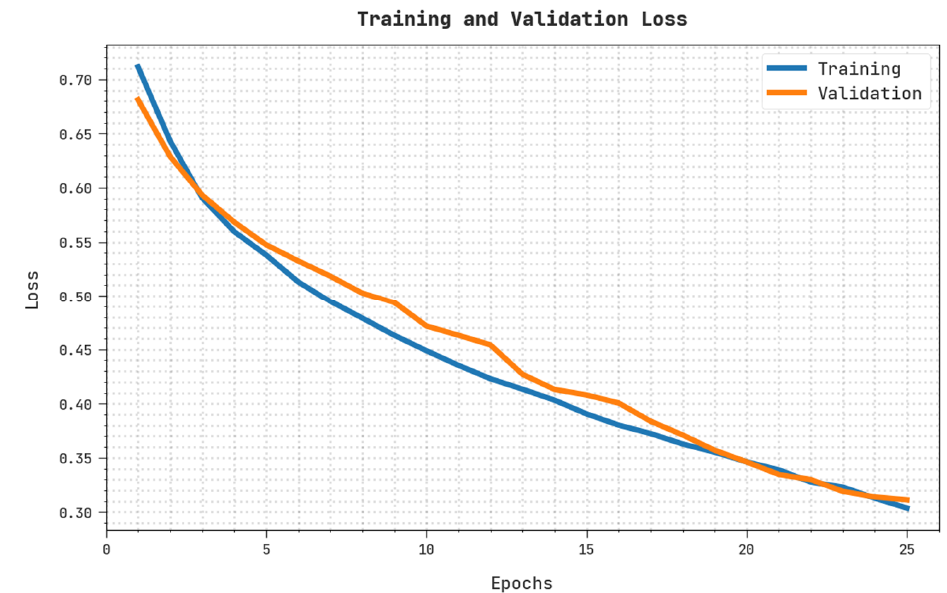
Figure 9. TRL and VLL analysis of OIDCNN-OPMDD approach.